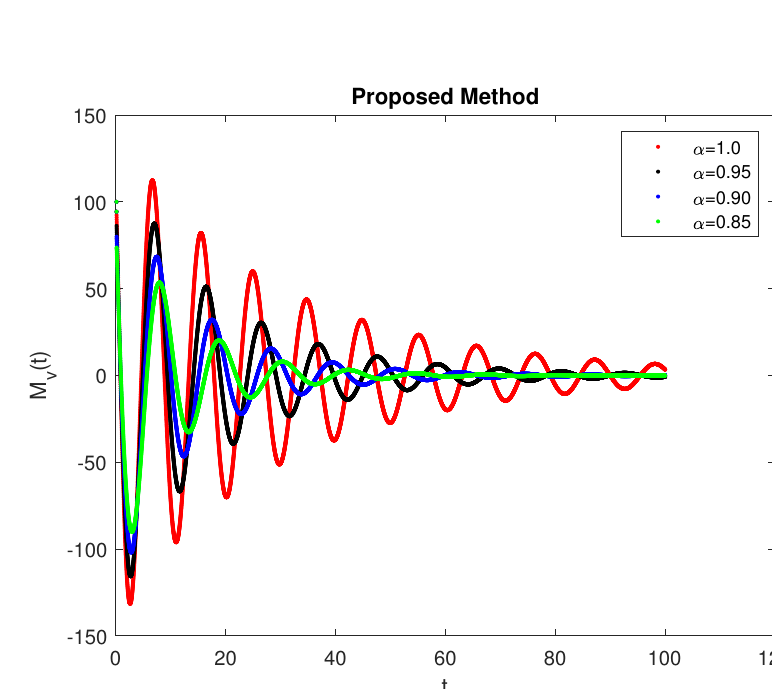
Figure 26: Numerical simulations for τ = 0.9 for Caputo-Fabrizio